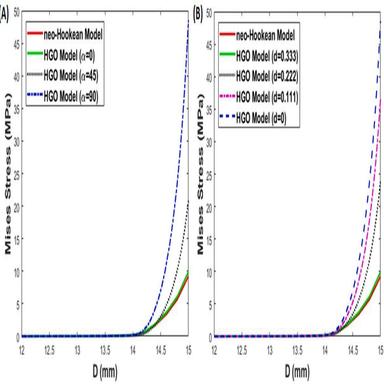
Influence of (A) fibre orientation and (B) fibre dispersion (in α = 90) in Tunica Albuginea (TA) on the response of penile tissue in IPP expansion simulation (k2 = 10 and k1 = 10 MPa).